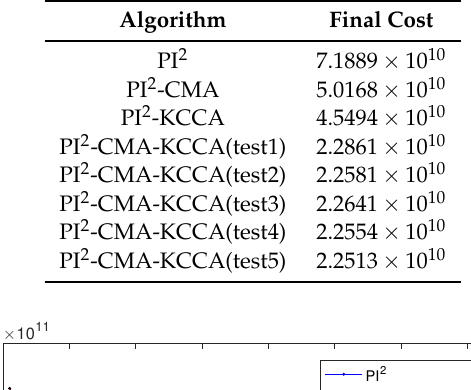
Table 4. The final cost of one via-point task with Swayer.